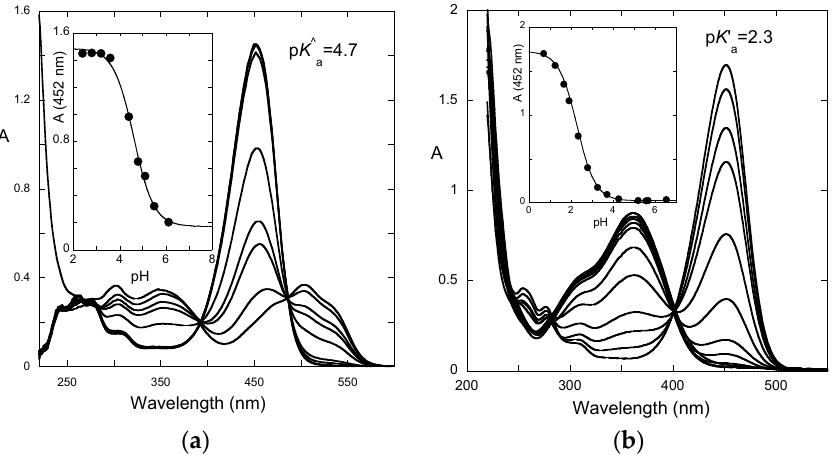
Figure 5. pH-Dependence of the UV-visible spectrum of P3; ( a ) recorded at pseudo-equilibrium (all species except the trans -chalcone); and ( b ) recorded at full equilibrium (all species including the trans -chalcone).